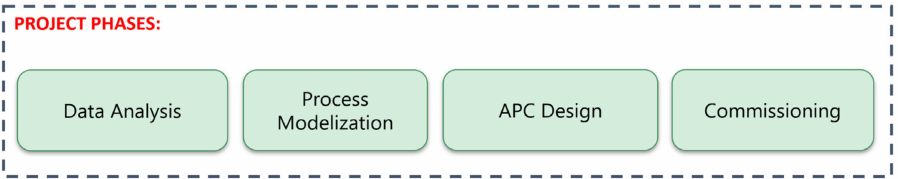
Figure 4. Schematic representation of the control specifications and of the proposed control solution.